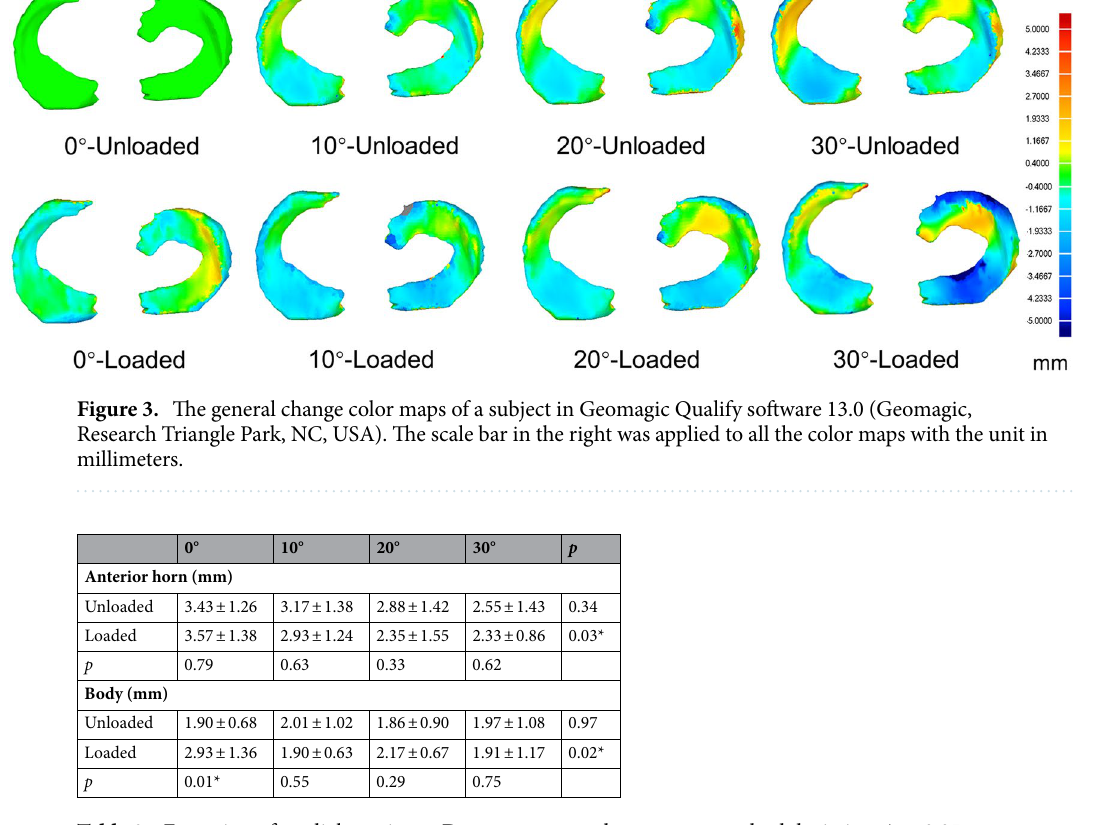
Table 2. Extrusion of medial meniscus. Data are presented as mean ± standard deviation. *p < 0.05.